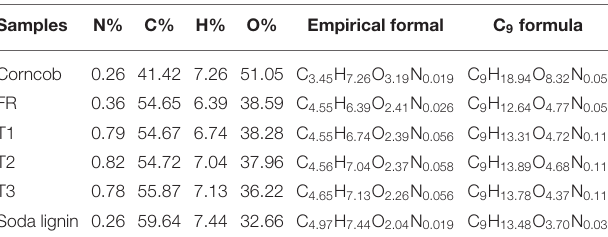
TABLE 1 | Elemental analysis and formula of corncob, furfural residue, and extracted lignin samples. Samples